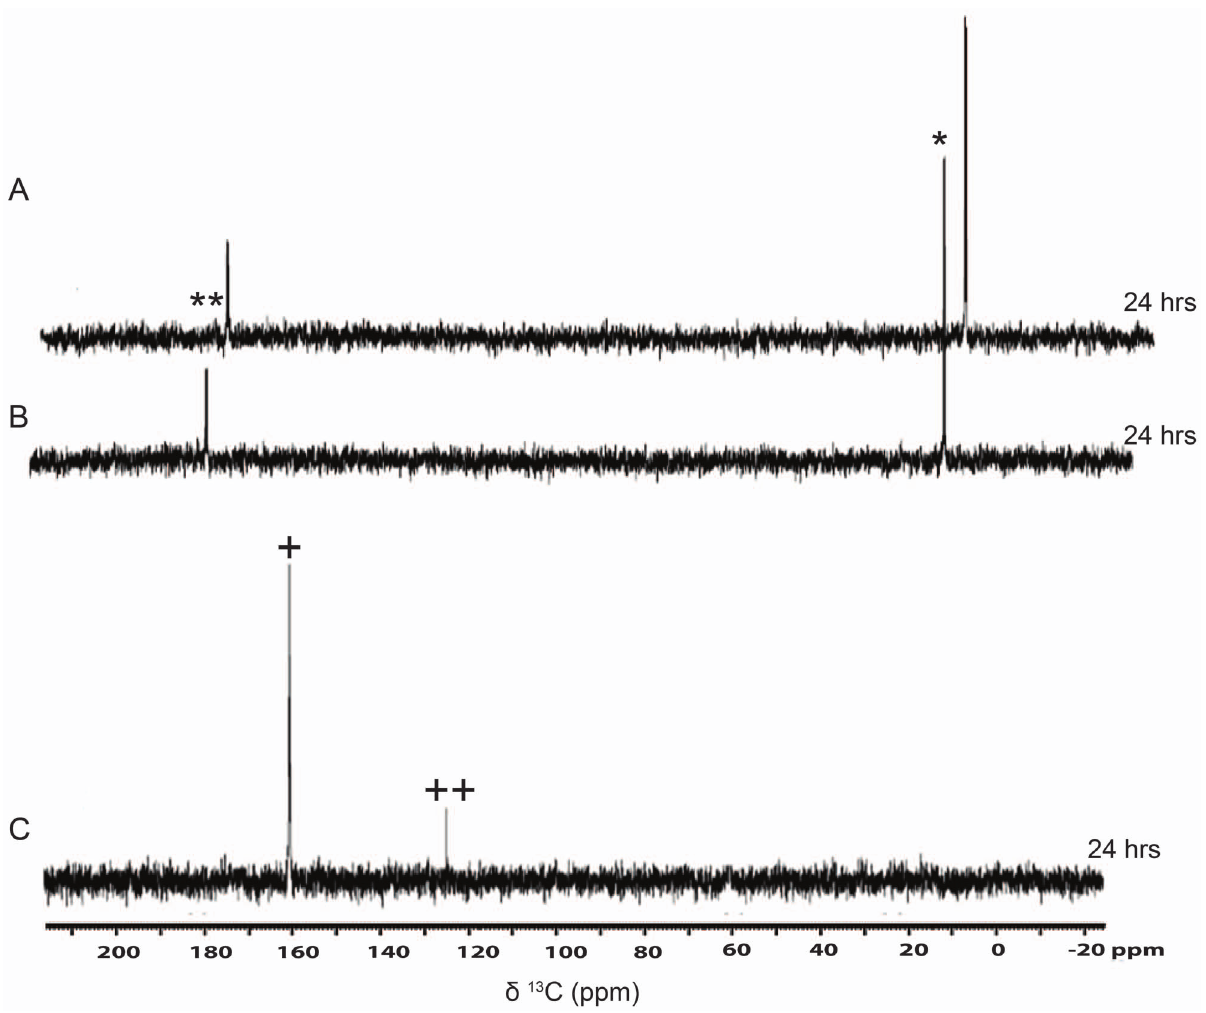
Figure 6. CCCP treated cells showed acetate uptake, but no conversion to metabolites in C.reinhardtii during heterotrophic and mixotrophic conditions. Assimilation kinetics of acetate and metabolite formation by C. reinhardtii cells, after twenty four hours of (A) mixotrophy and (B) heterotrophy following the addition of [1, 2- 13 C]-acetate to the TP medium containing CCCP (20 m M). Cells from different time points were pelleted, re-suspended in TP medium, followed by recording 1D proton decoupled [ 13 C]-NMR spectra. (C) Control heterotrophic cells without CCCP, but processed similarly. (The signs * and ** represent methyl and carboxyl peaks, respectively, of [1, 2- 13 C]-acetic acid, and the signs + and ++ represent bicarbonate and CO 2aq peaks,